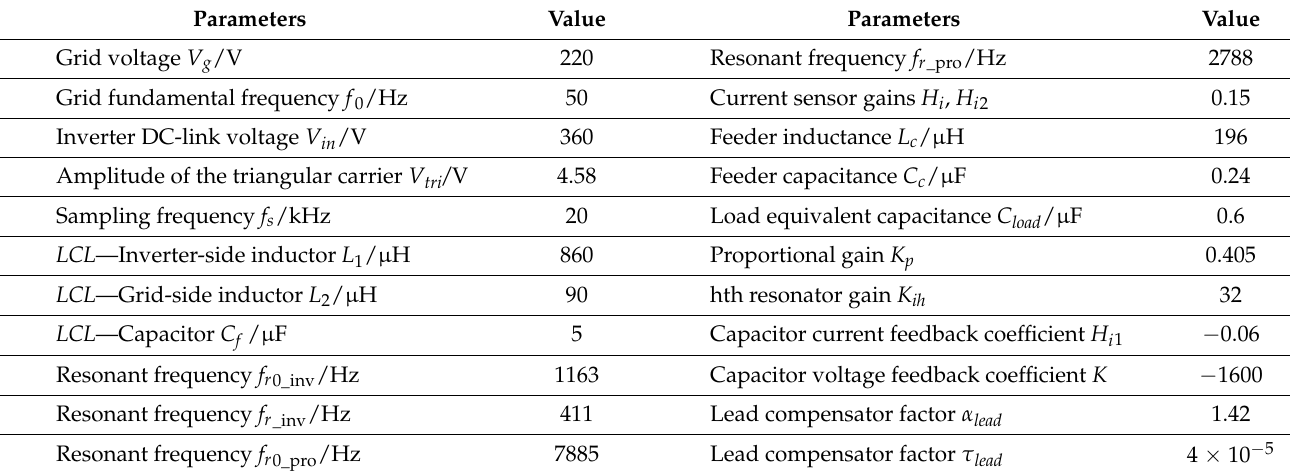
Table 1. Parameters of the main circuit and the